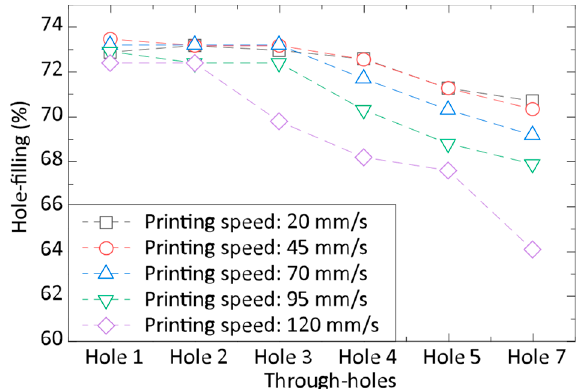
Figure 8. Hole-filling by the solder paste in the seven consecutive holes at different printing speeds.